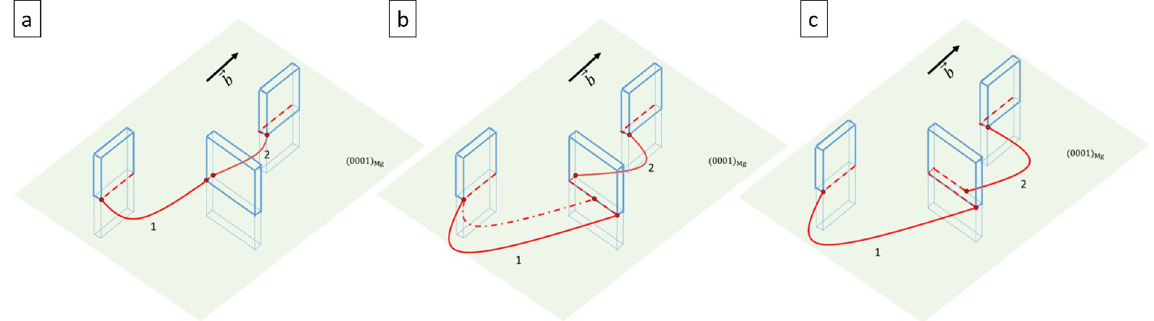
Figure 2. Schematics of precipitate-dislocation interactions depicting progression of the experimental images shown in Fig. 1. β 1 precipitates are oriented perpendicular to the basal plane depicted as plates with broad facets. Dislocations are constrained in the basal plane and the interfacial dislocations are represented by red dashed